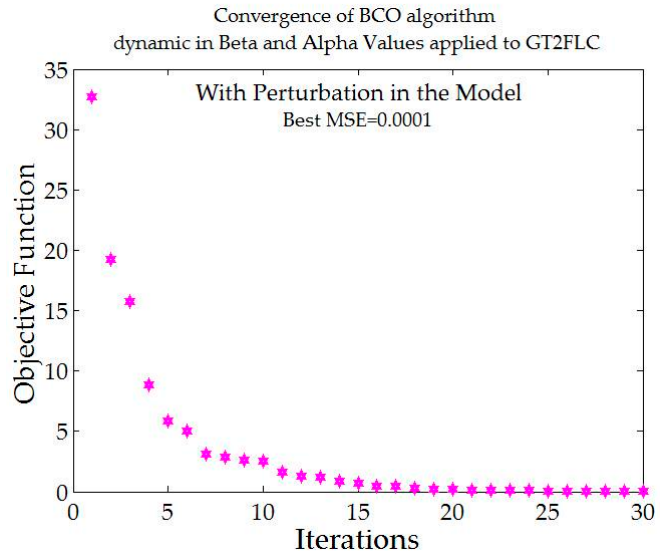
Figure 21. Convergence of the MSE error with adjustment in alpha and beta values.